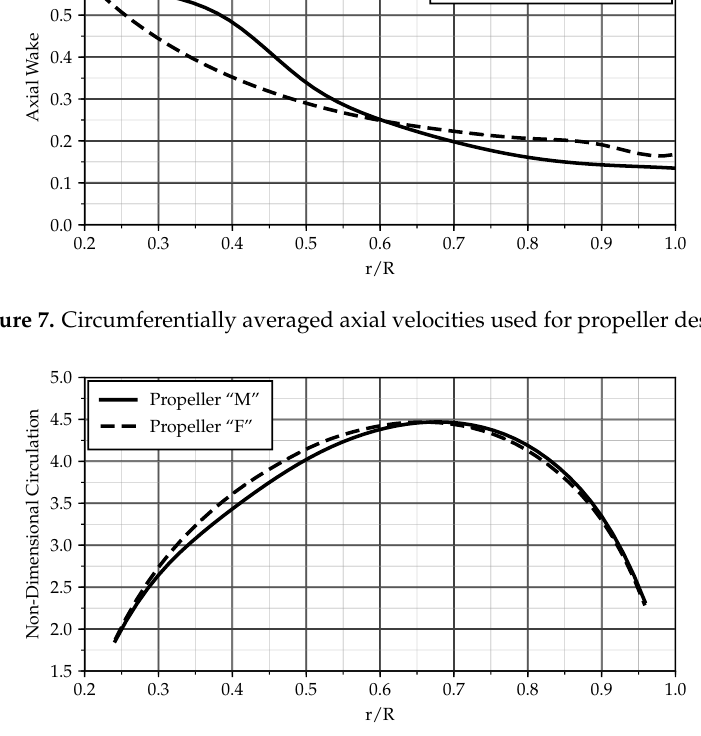
Figure 8. Radial circulation